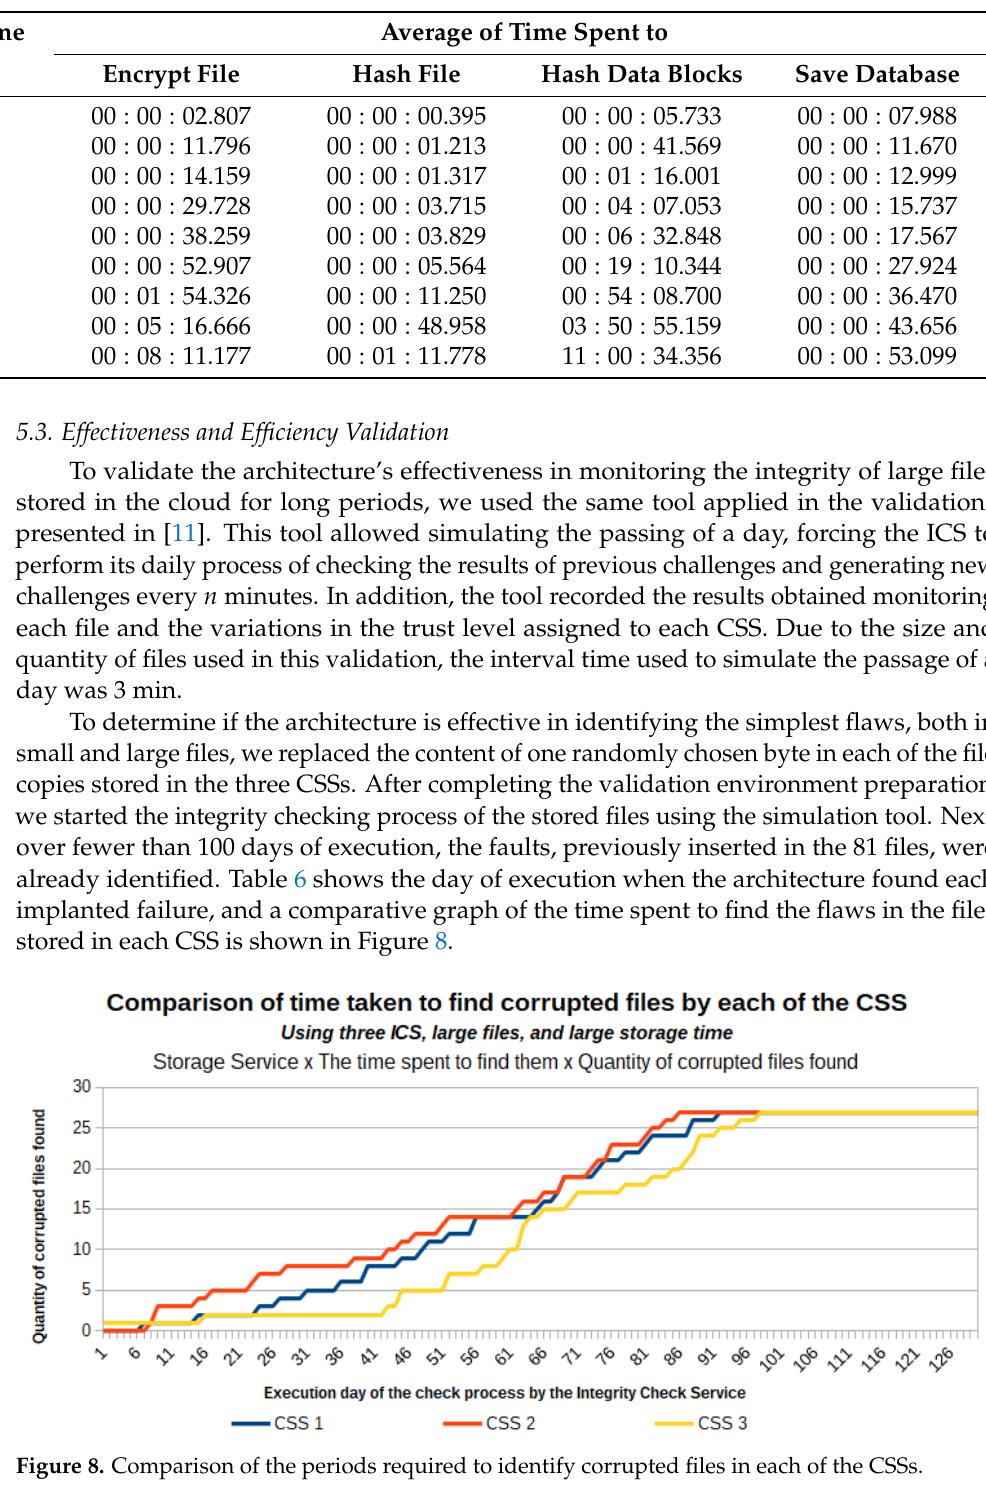
Table 5. Summary of time period spent preparing files for storage.